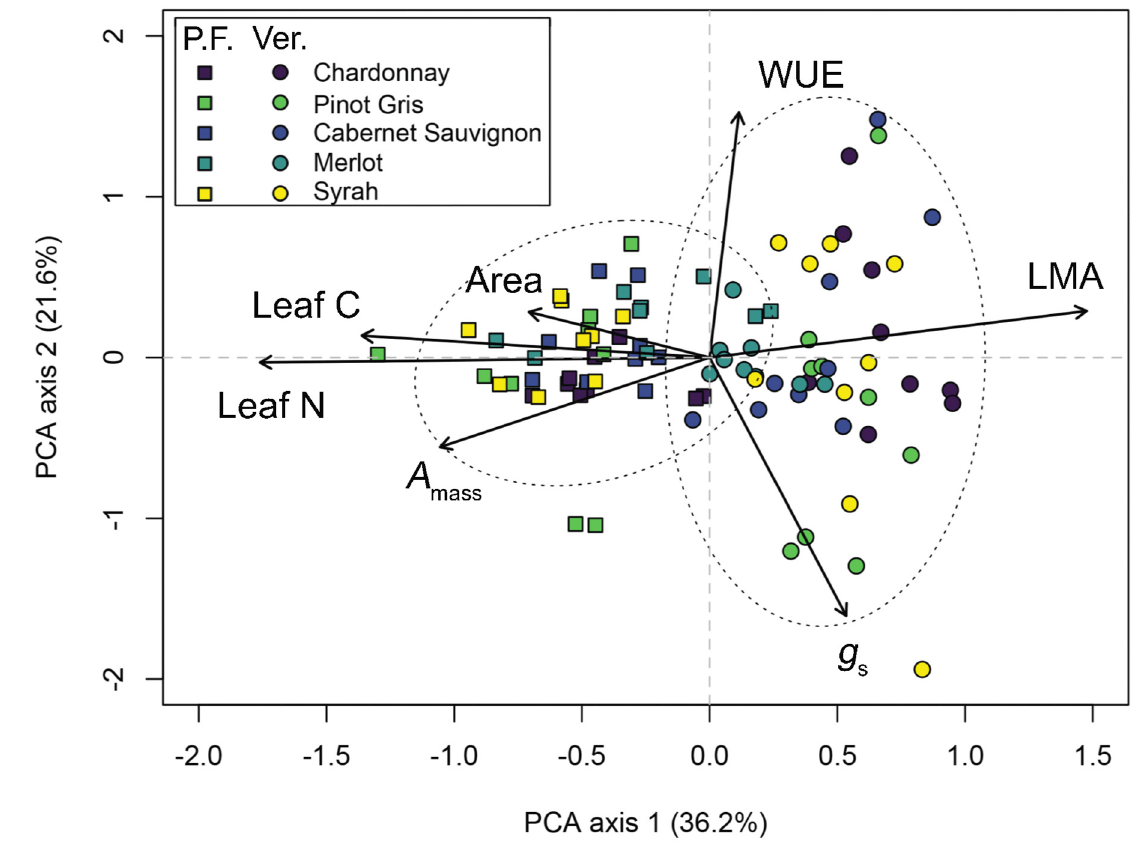
Figure 4. Principal components analysis (PCA) evaluating multivariate trait relationships across five wine grape varieties across two growth stages. Only seven of nine traits quantified in this study were included here, due to strong collinearity in certain traits (see Figure 3). Colours correspond to different varieties, whereas symbols represent different growth stages (post-flowering and veraison, “P.F.” and “Ver.”, respectively). To aid in visualization, also presented here are 95% confidence ellipses surrounding the two different growth stages which explained 22.9% of the variation in the seven traits analyzed here. Associated permutational analysis of variance (PerMANOVA) and relationships between individual traits and PCA axes are presented in Tables S2 and S3. Trait abbreviations are as follows: A max : light saturated maximum photosynthetic rate on a per-unit leaf area basis; A mass : light saturated maximum photosynthetic rate on a per-unit leaf mass basis; g s : stomatal conductance; WUE: instantaneous water use efficiency; LMA: leaf mass per unit area.